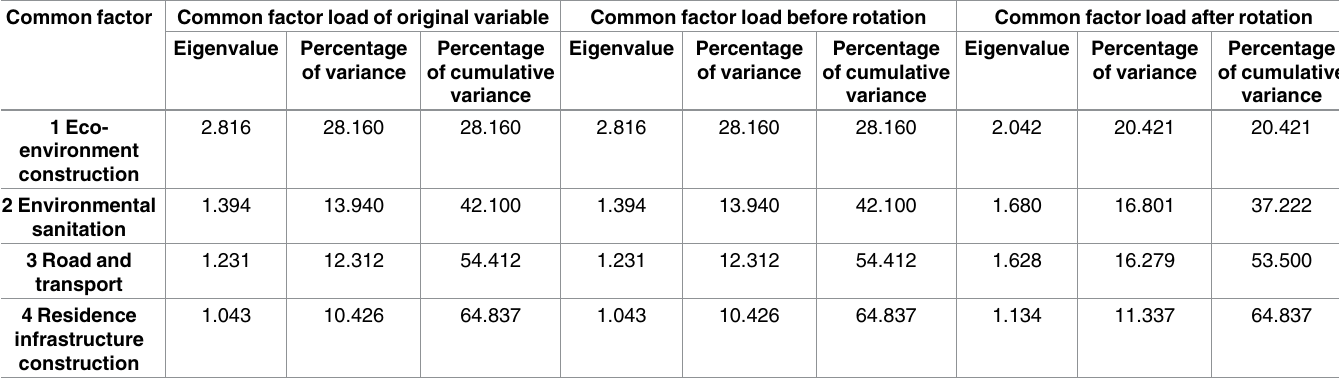
Table 2. Eigenvalue and contribution rate of common factors for comprehensive municipal infrastructure development.